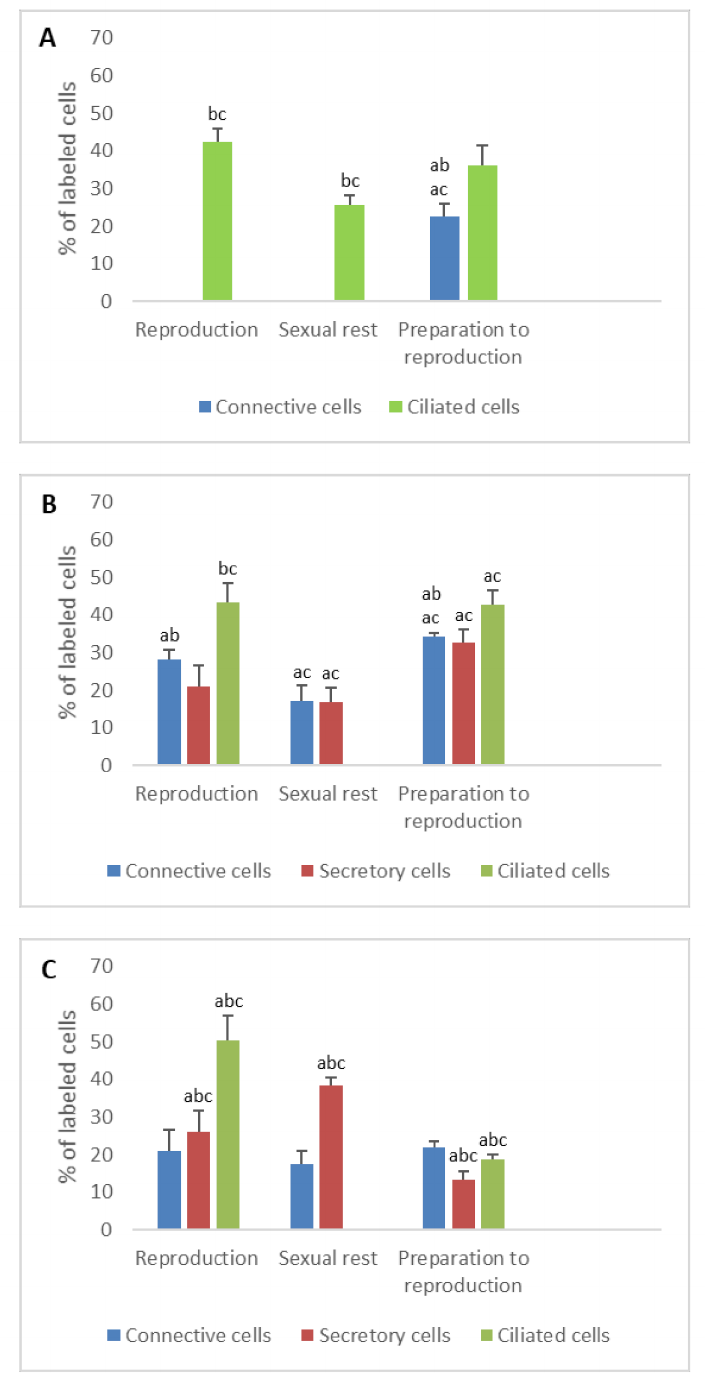
Figure 5. Percentage of FSHR immunodetected in the different cell types of the genital tract of Typhlonectes compressicauda before ovulation and during the reproduction period (pregnant females) and sexual rest (quiescent females). Significant differences (ANOVA, α = 0.05) between the 3 groups of females (a: before ovulation; b: pregnant females; c: quiescent females) are reported with the letters a, b, c. ( A ) Ostium (connective cells n = 6, Pr > F: 0.002, ciliated cells n = 6, Pr > F: 0.055); ( B ) Tubal part (connective cells n = 6, Pr >F: 0.006, secretory cells n = 6, Pr > F: 0.07, ciliated cells n = 6, Pr > F: 0.002); ( C ) Uterus (connective cells n = 6, Pr > F: 0.575, secretory cells n = 6, Pr > F: 0.016, ciliated cells n = 6, Pr > F: